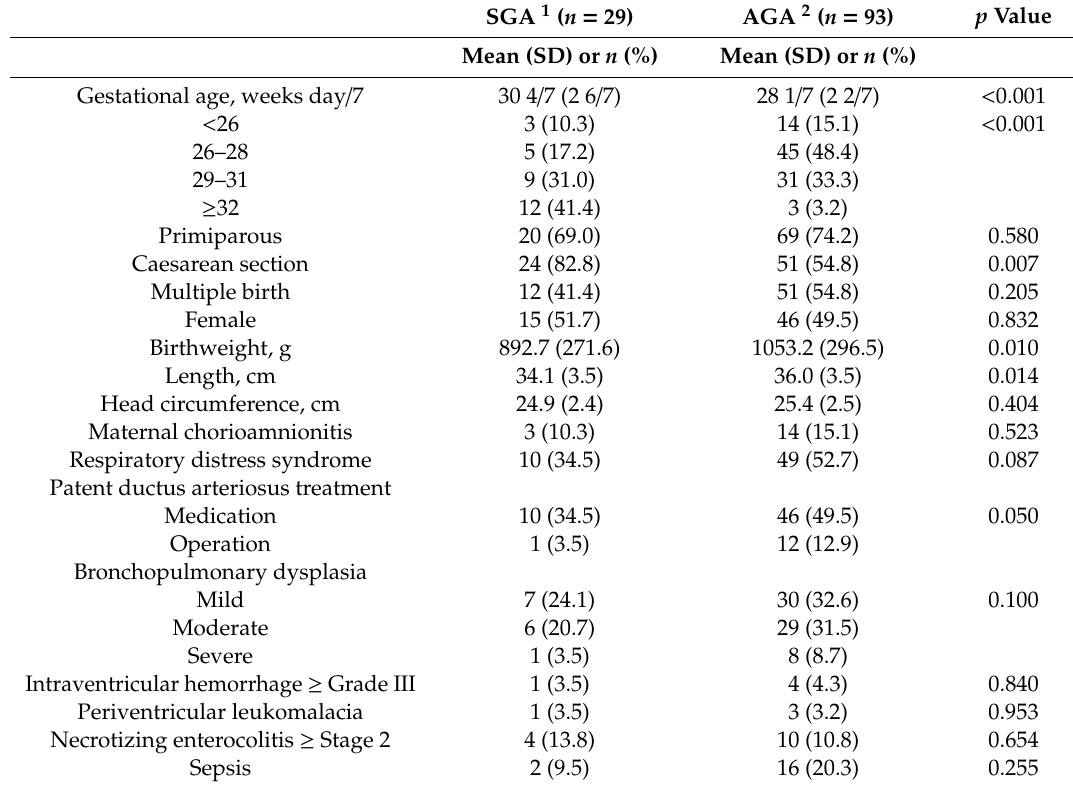
Figure 1. Flow diagram of the study population. Table 1. Characteristics and perinatal morbidities of the study population.